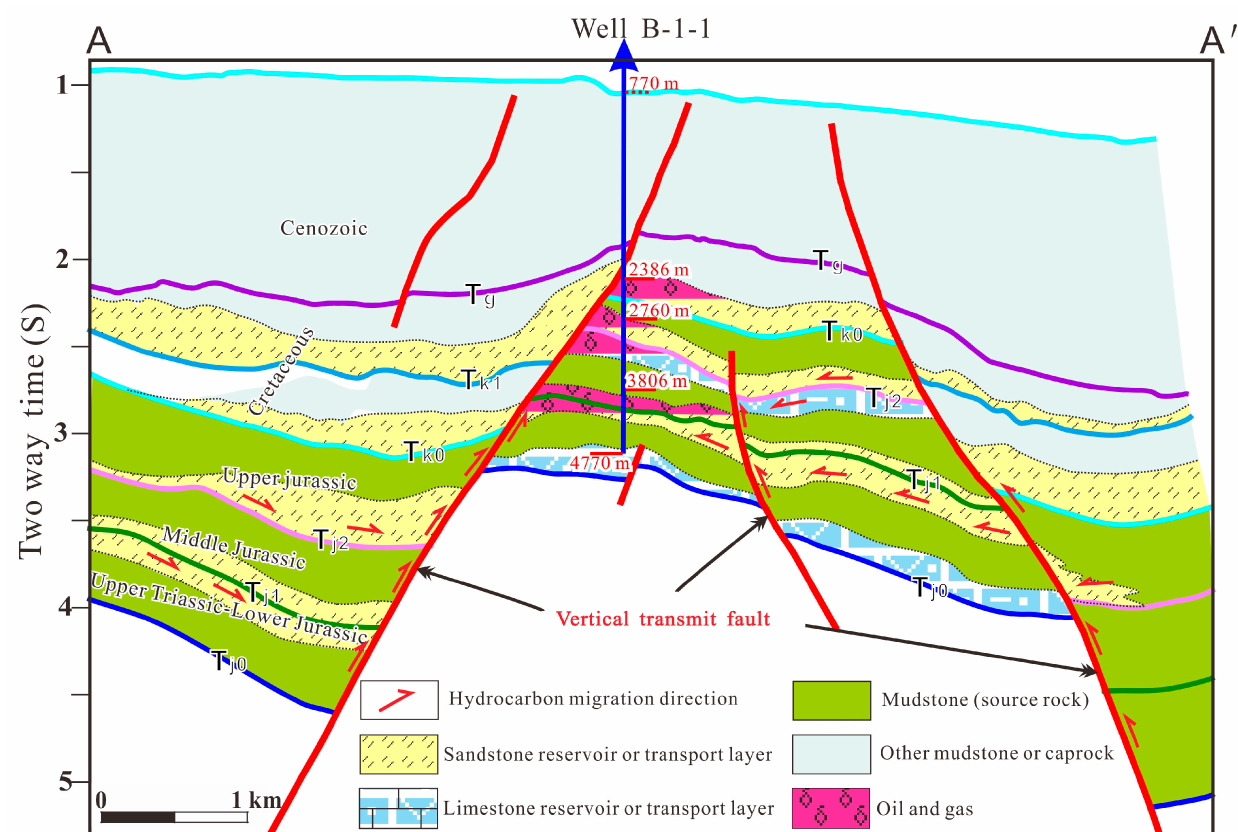
Figure 10. Prediction of the B-1 structural reservoir-forming model displaying elements of the local petroleum